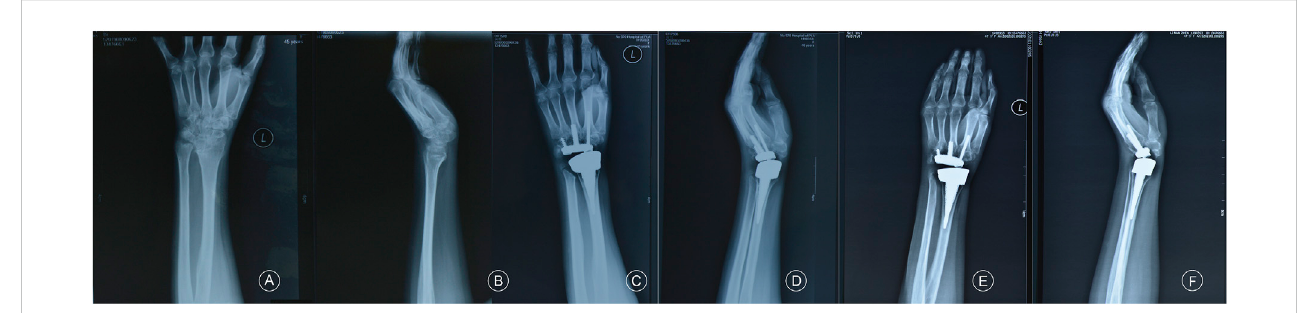
FIGURE 3 Osteoarthritis of the left wrist joint in a female patient aged 46 years. (A,B) : preoperative anteroposterior and lateral radiographs, (C,D) : postoperative anteroposterior and lateral radiographs at 6 months, (E,F) : postoperative anteroposterior and lateral radiographs at 12 months.